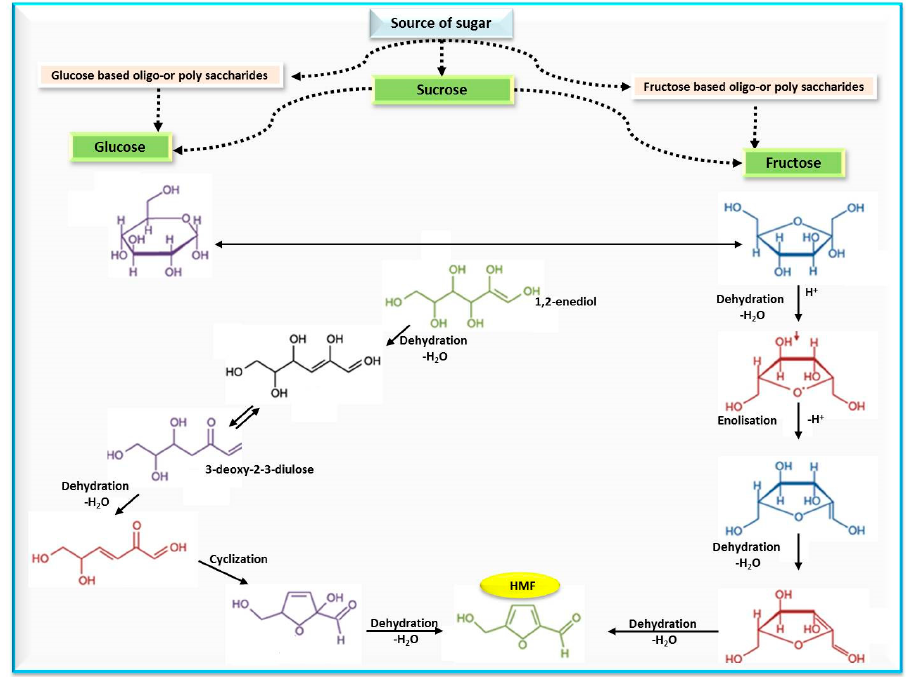
Figure 2. Mechanism of HMF formation from simple sugars.